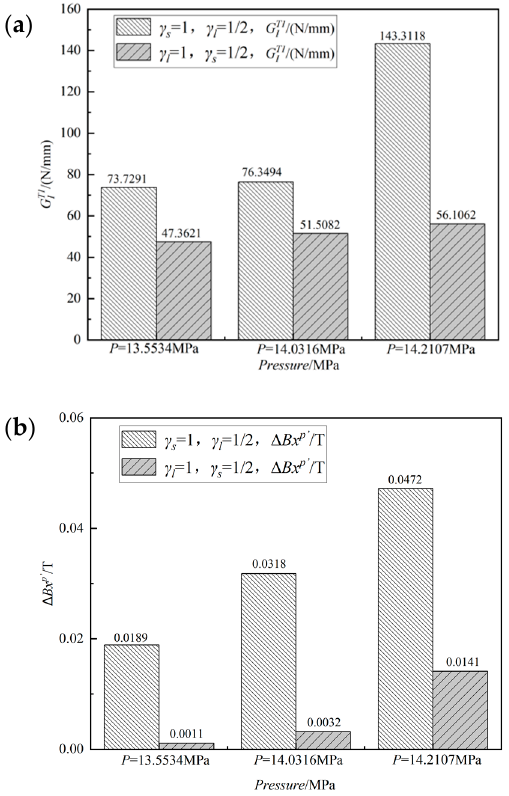
T 1 − γ − γ s , l , G I I